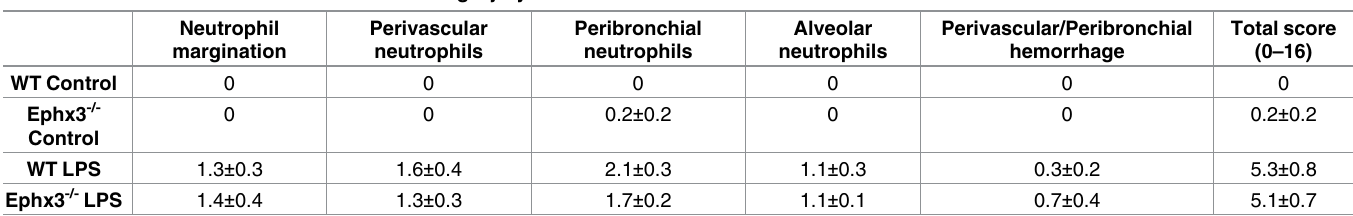
Table 1. Inflammation scores in LPS-induced lung injury model.